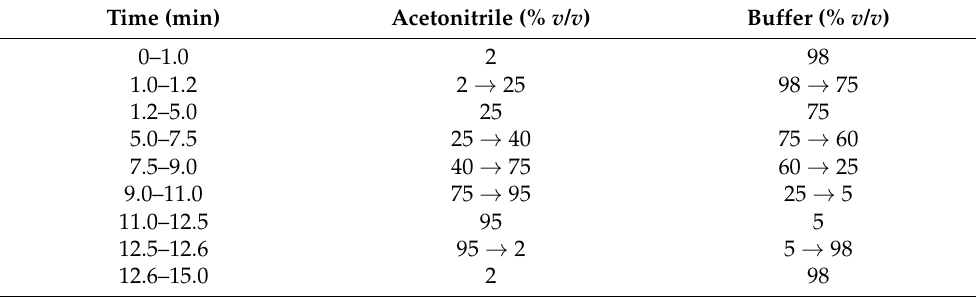
Table 2. Gradient for the separation of enalapril and related substances.